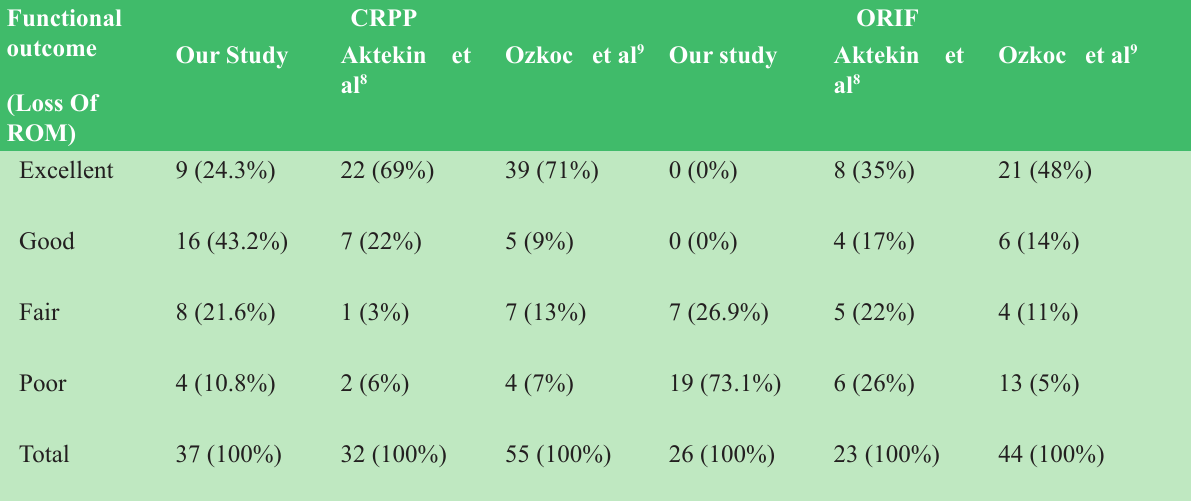
Table 9: Comparison of functional outcome in different studies based on Flynn’s criteria